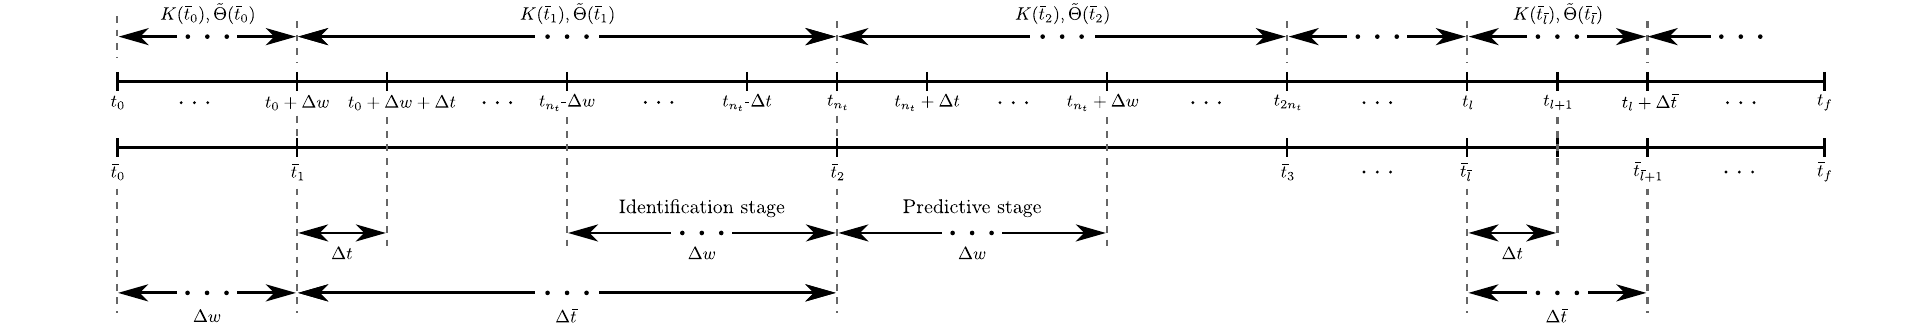
Figure 4. Time horizon of the proposed chaotic adaptive tuning strategy for controller gains in the BLDC